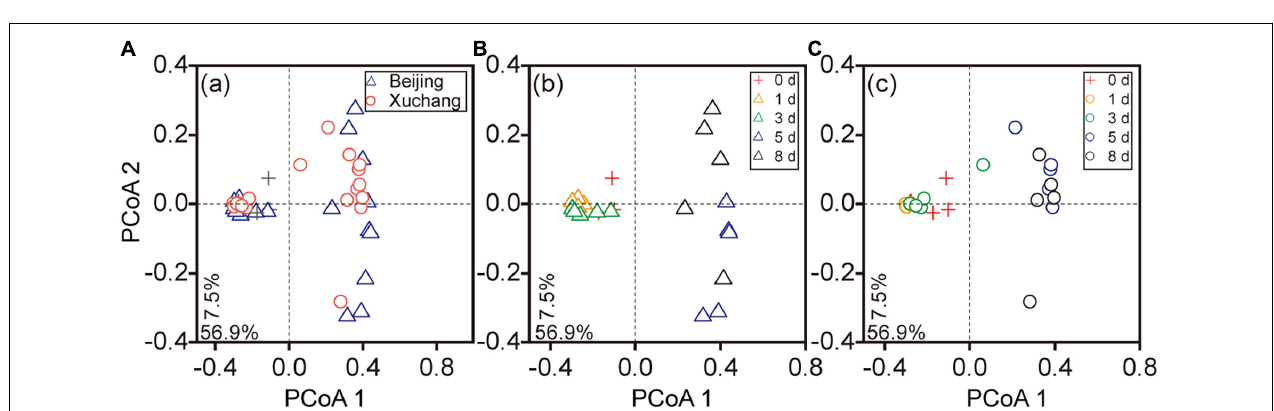
FIGURE 3 | The richness [number of observed operational taxonomic units (OTUs)] and Simpson index of bacterial communities on decaying earthworm. Bacterial diversity showed clear temporal pattern in both native soil treatment (A,C) and non-native soil treatment (B,D) . The richness (A,B) and Simpson index (C,D) of bacterial communities showed higher values before day 3 and then decreased after day 3. The temporal changes of bacterial richness were marginally different between native soil and non-native soil either before day 3 ( E , p = 0.06) or after day 3 ( E , p = 0.07). The Simpson index was significantly different in two soils after day 3 ( F , p = 0.03).